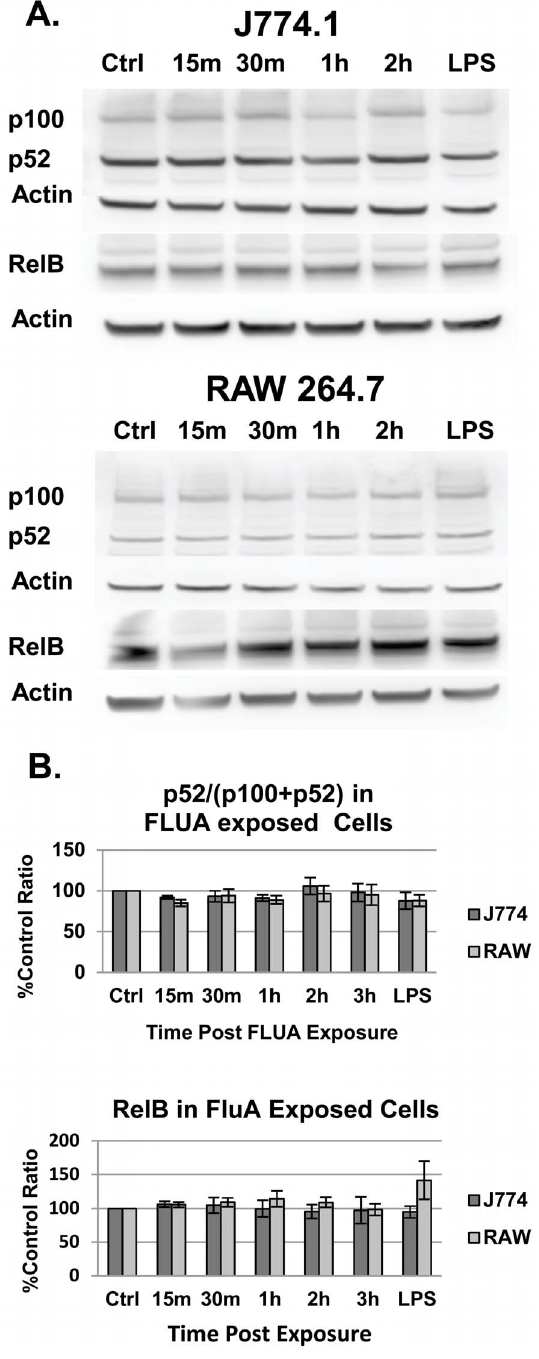
Figure 2. The non-canonical NF k B pathway is not activated by X-31 exposure. The percent of the total p52 and p100 protein in the activated p52 form did not change from that in the control mock infected cells. The expression of RelB, the partner of p52, was also unchanged. A. Representative Western blots. B. Densitometry graphs from the Western blots. Means are shown 6 SEM, n=4 to 7 independent experiments depending on time point.